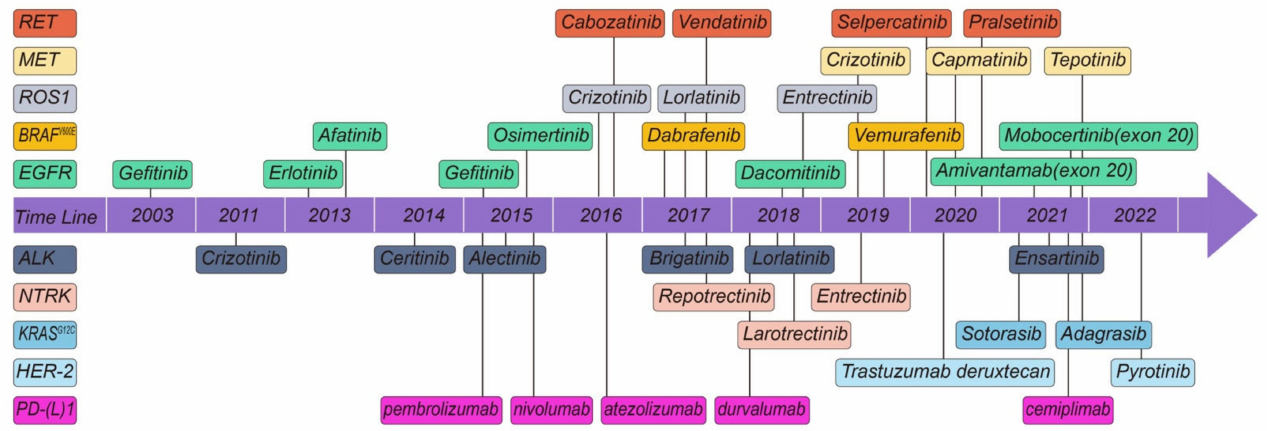
Figure 2. Timeline of targeted drugs which FDA approved for oncogene-driven